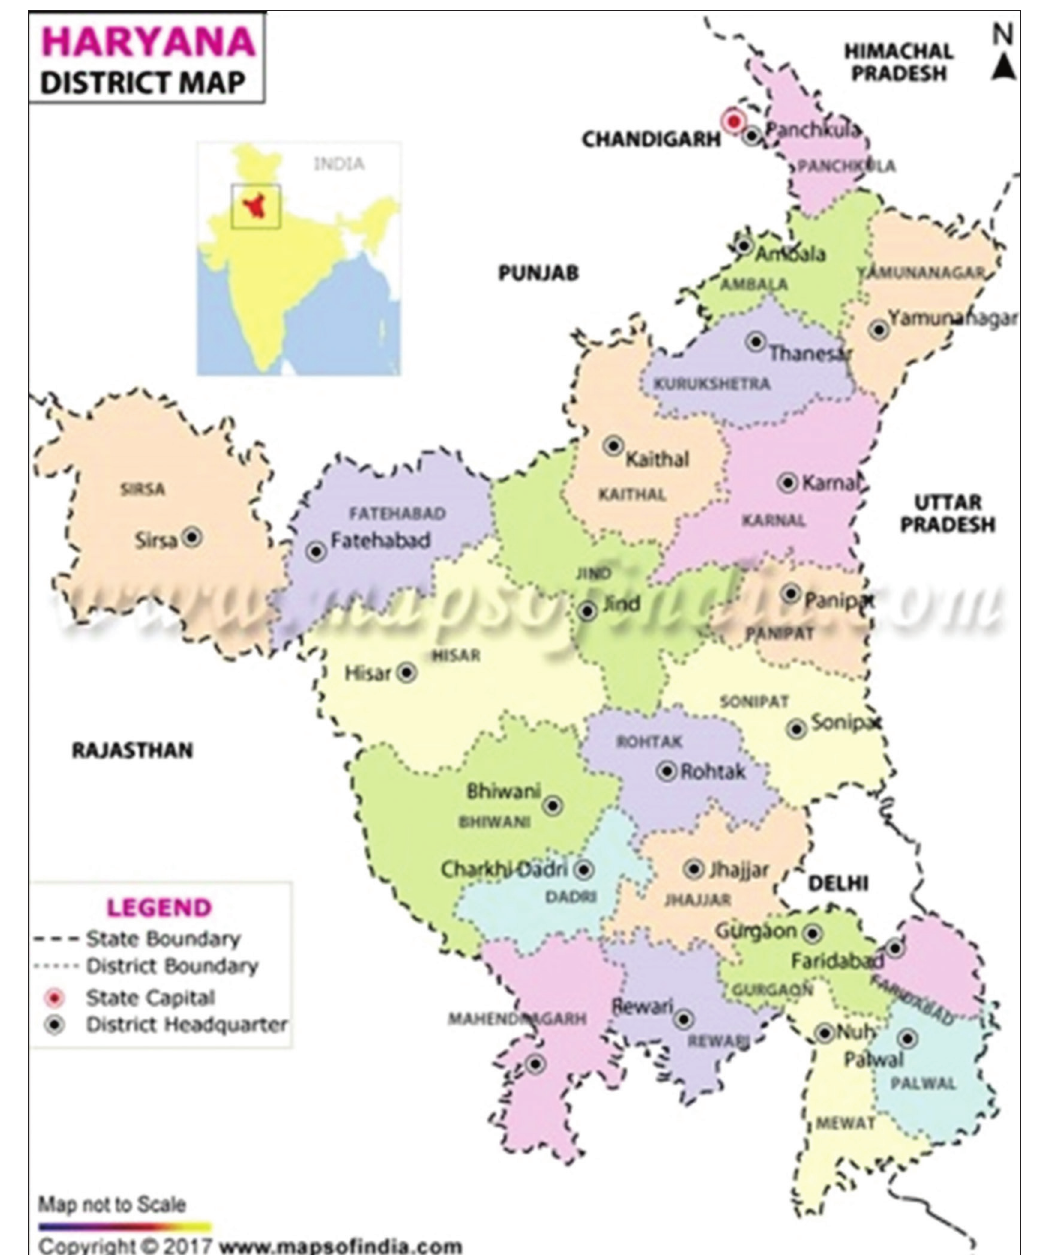
Figure-1: Study area - Haryana state districts depicted on India